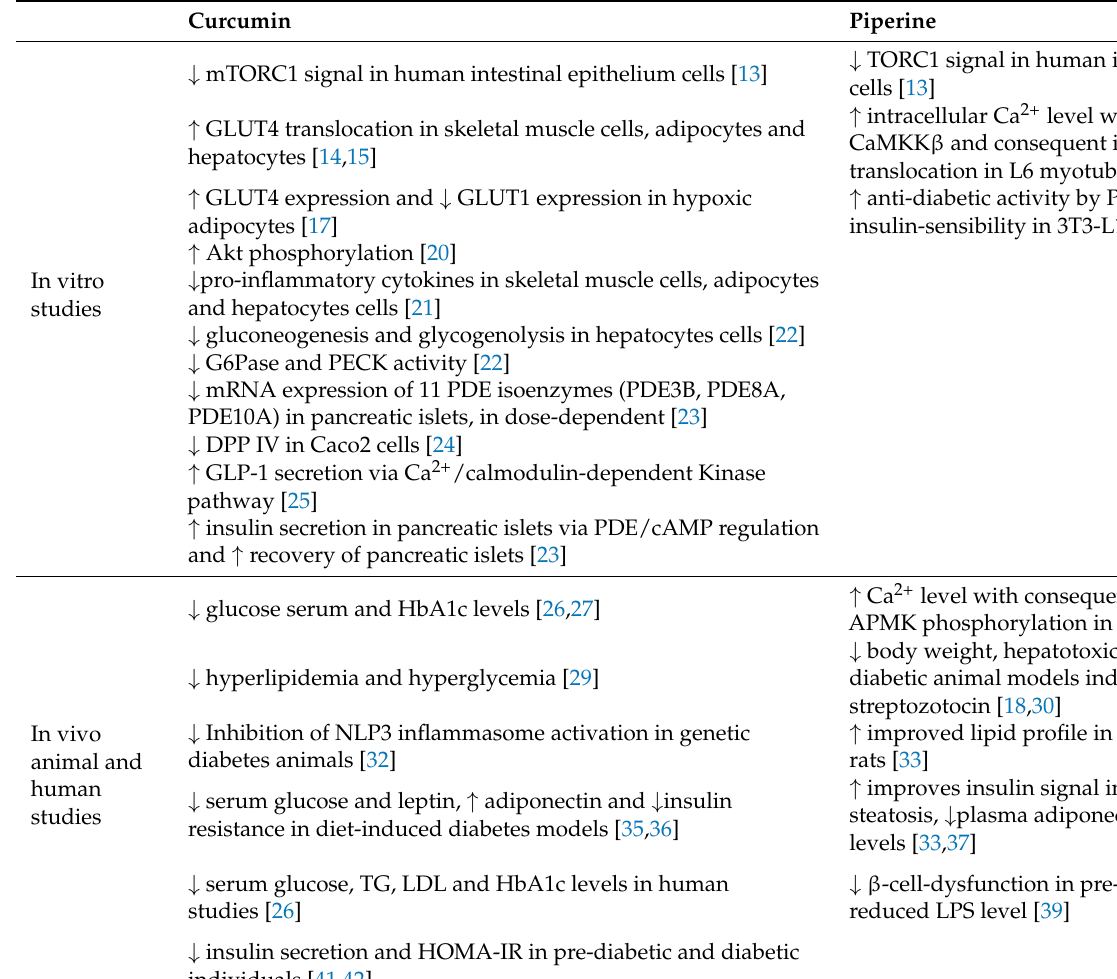
Table 1. Summary of the anti-diabetic activities of curcumin and piperine as single agents and in